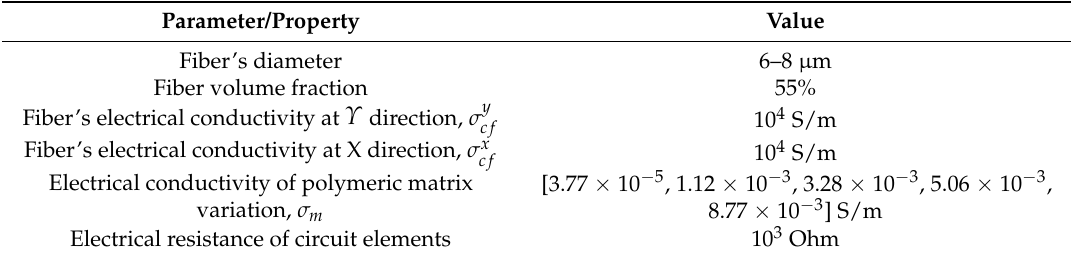
Table 1. Input parameters and materials properties in the meso-scale model.